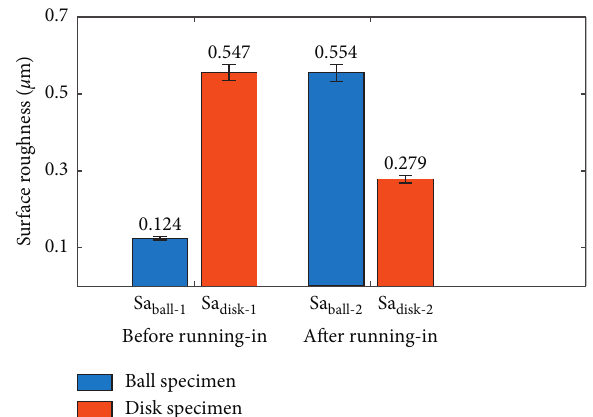
Figure 3: The surface roughness of friction